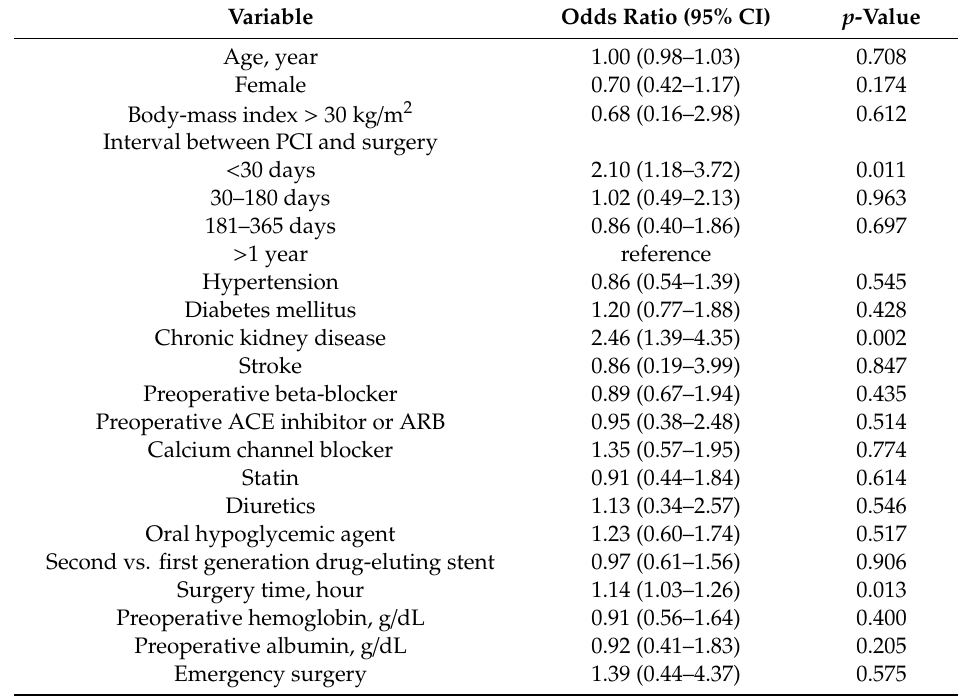
Table 4. Multivariable logistic regression analysis to predict postoperative major adverse cardiovascular and cerebral event in patients undergoing noncardiac surgery after coronary stent